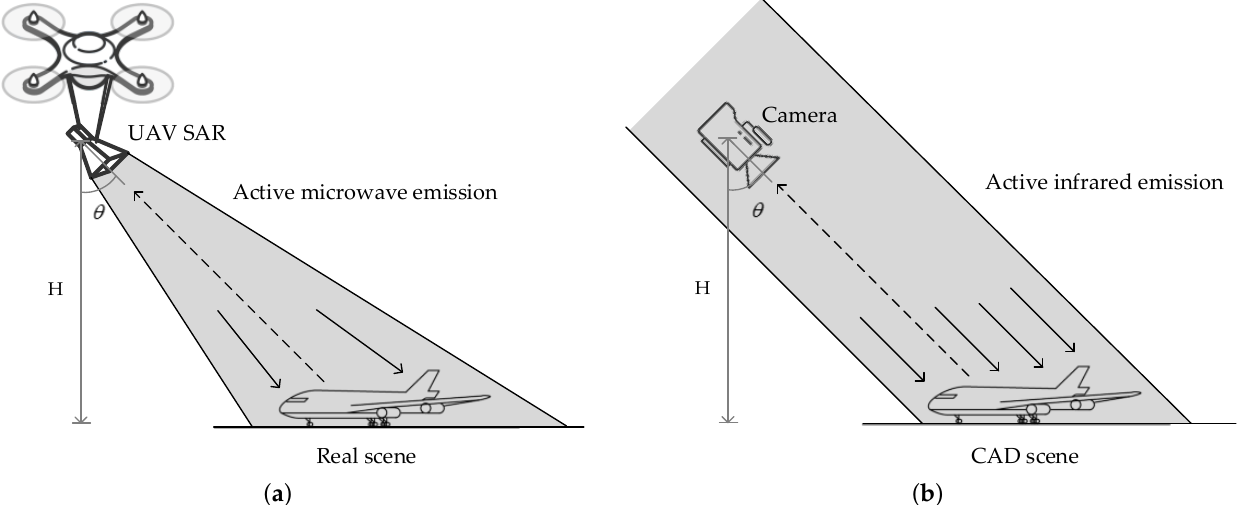
Figure 3. Comparison of SAR imaging and simulated optical imaging. ( a ) Schematic of SAR imaging; ( b ) Schematic of simulated optical imaging referring active infrared